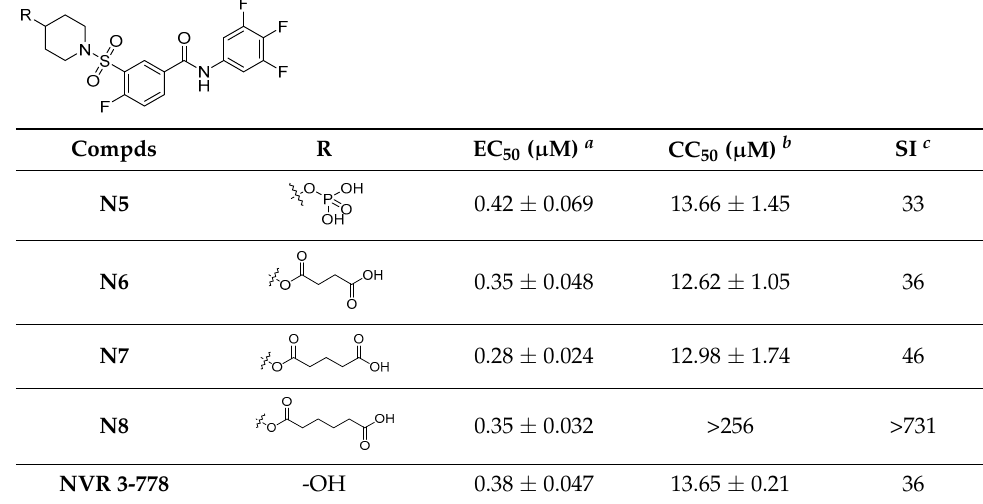
Table 1. Anti-HBV activity and cytotoxicity of the newly synthesized compounds.